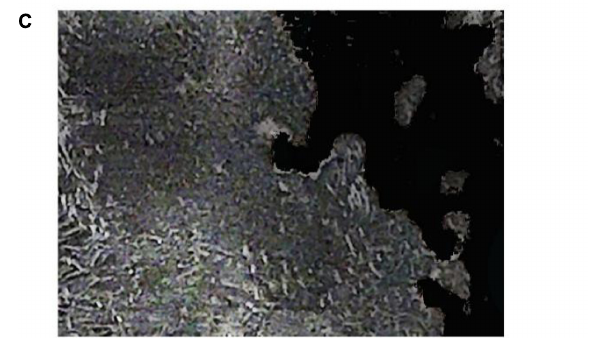
FIGURE 14 | Process of image manipulation by MATLAB. (A) Original. (B) Clustering segmentation and image enhancement. (C) Image binarization and expansion and